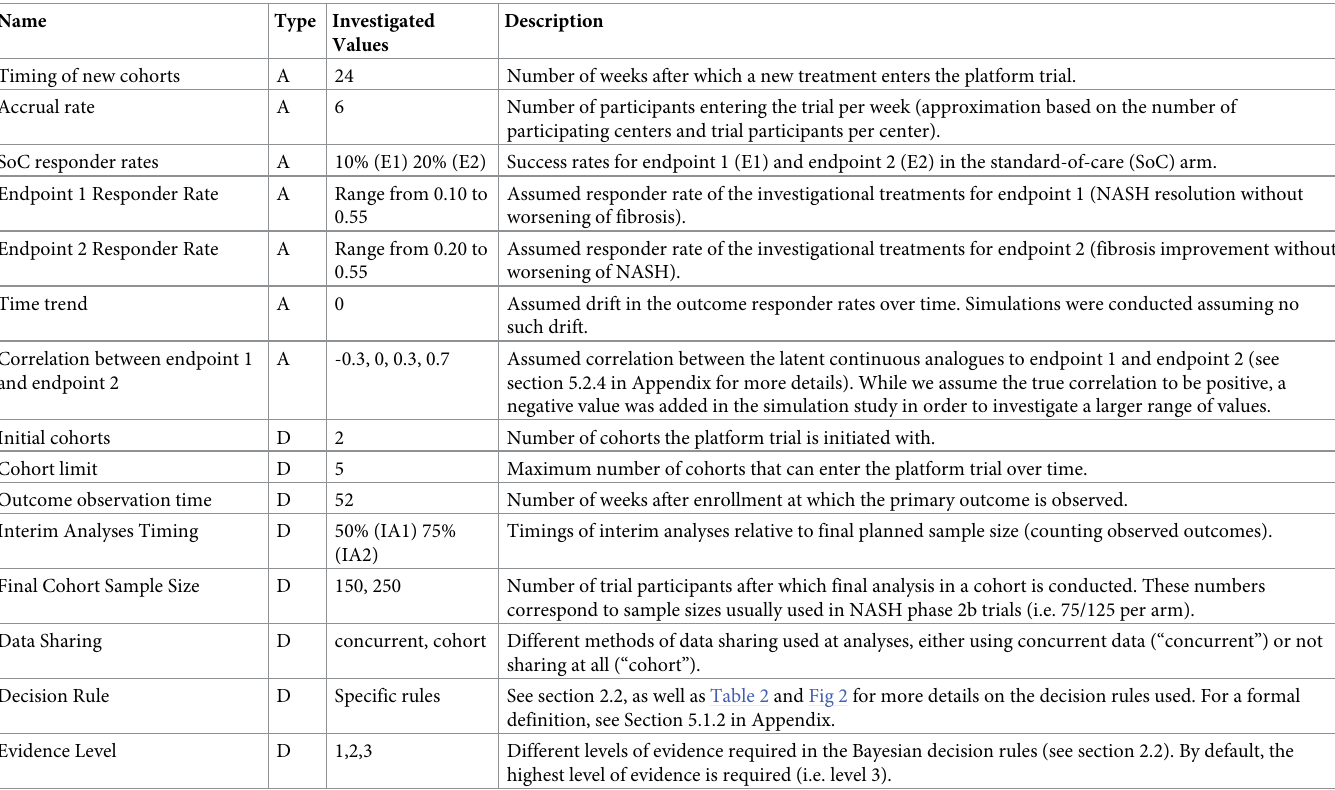
Table 3. Specification of important simulation parameters. Values are either fixed or varied in different simulation scenarios. For different simulation parameters, we differentiate between parameters that are considered a design choice (“D”) and parameters that are considered an assumption (“A”) regarding the future course of the plat- form trial or treatment effects (see second column